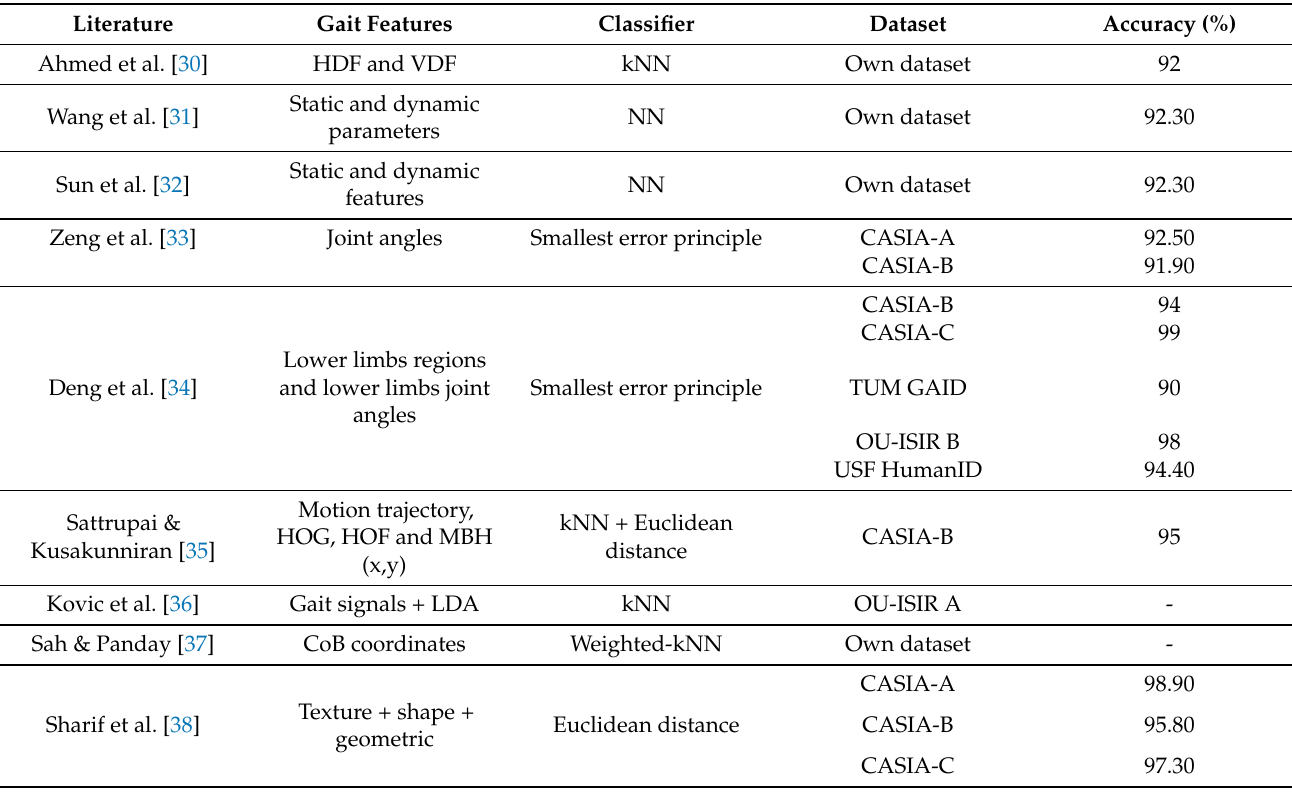
Table 1. Summary of model-based